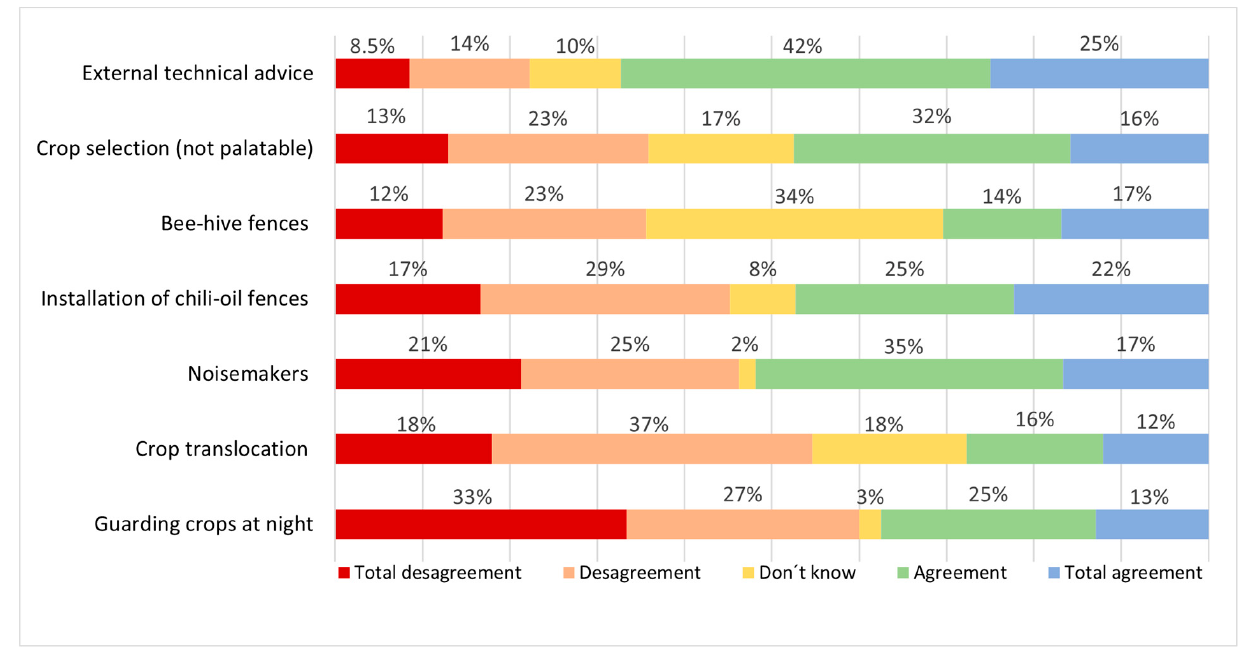
Figure 4. Farmers´ perception about the effectivity of farm-based mitigation measures to reduce Figure 4. Farmers’ perception about the effectivity of farm-based mitigation measures to reduce crop crop damage by elephants. damage by elephants. Table 1. Results of the random parameter logit models (457 face-to-face wildlife rangers and 12 choices per individual; number of observations = 5484; Log likelihood function = − 6410.09; restricted log likelihood = − 8826.16; McFadden Pseudo R-squared = 0.2737; replications for sim- ulated probs. = 500; used Halton sequences in